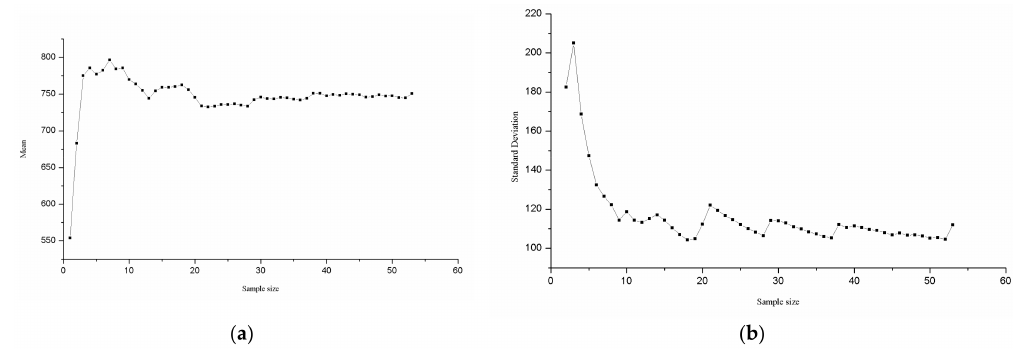
Figure 5. Trends of statistical parameters of the annual precipitation sequence of Baishan station as sample size increases. ( a ) Mean value; ( b ) Mean